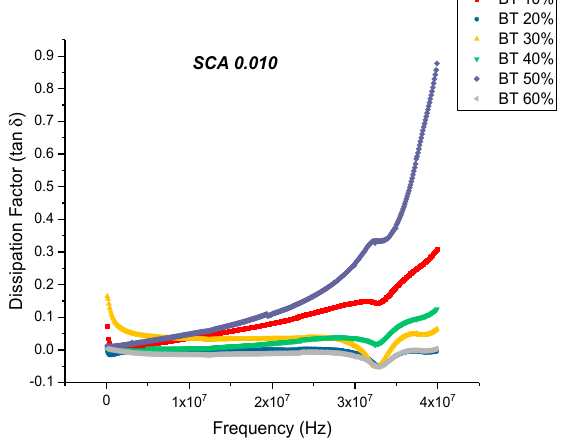
Figure 8. The dissipation factor of the BaTiO 3 -epoxy composite that were fabricated using BaTiO 3 nanoparticles which were surface modified using 0.010 SCA is plotted as a function of frequency where the volume fraction of BaTiO 3 is varied from 0.1 to 0.6. The maximum value is 0.1106 for BaTiO 3 at 0.5 volume fraction. For the samples that were surface treated using 0.015 concentration of silane coupling agent, the relative permittivity shows an increasing tendency with the loading levels of the nanoparticles as shown in Figure 9. The maximum permittivity values at 20 MHz was found to be 41.76 at 50% volume fraction of BaTiO 3 . This value is a 27% increase compared to the permittivity of the SCA 0.015 sample. The loss factor begins to increase with increasing frequency and can be attributed to the decrease in